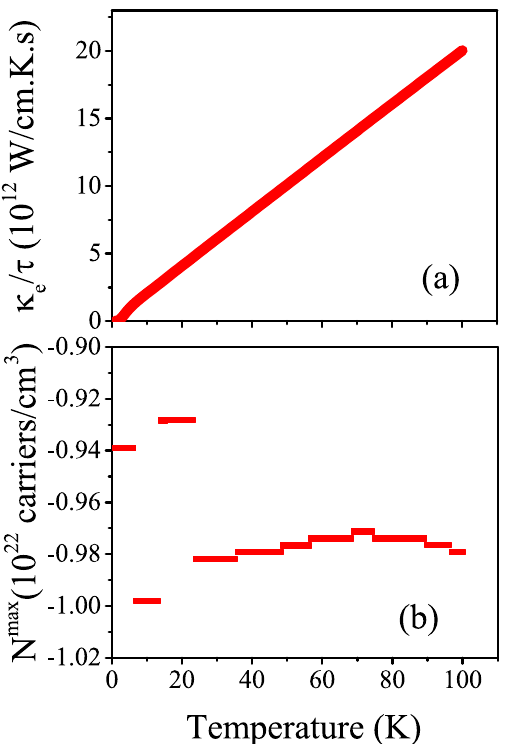
Figure 13. ( a ) Maximum values of spin up electronic thermal conductivity per relaxation time ( τ ), i.e., κ max e /τ , of electron/hole doped CeIn 3 versus temperature for T ≤ 100 K calculated using GGA+U with U eff = 5.5 eV for the P = 0 pressure. Doping levels related to the κ max e /τ are displayed in the ( b ) panel.